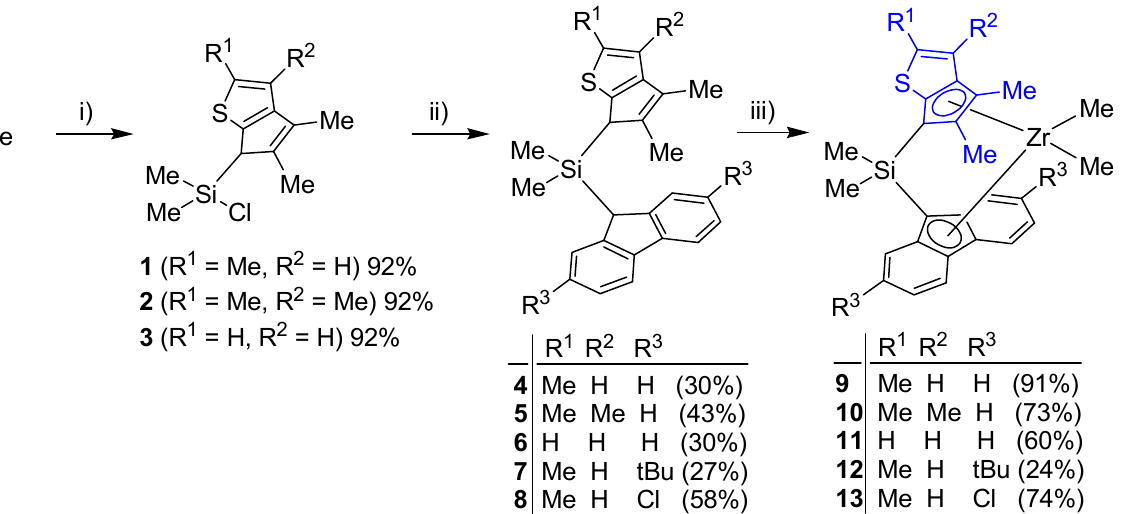
Scheme 2. Syntheses of Me 2 Si-bridged ansa -zirconocene complexes coordinated by thiophene-fused cyclopentadienyl and fluorenyl ligands: ( i ) Me 2 SiCl 2 in toluene, ( ii ) 2,7-R 32 -fluorenyl-Li in THF, ( iii ) nBuLi (2.0 eq) in THF and then addition of MeMgBr (2.3 eq) and ZrCl 4 ⋅ (THF) 2 . Because the solids precipitated in toluene were not suitable for X-ray crystallography, we grew single crystals of 9 in a CH 2 Cl 2 solution via the slow evaporation of CH 2 Cl 2 in a closed chamber containing methylcyclohexane. The bond lengths measured by X-ray crystallography suggested an η 3 -binding mode for the fluorenyl ligand and an η 5 -binding mode for the thiophene-fused cyclopentadienyl ligand; the two Zr–C bonds in the fluorenyl ligand (Zr–C3, 2.8122(31) Å and Zr–C4, 2.807(3) Å) were too long to be considered chemical bonds (Figure 1). The closest Zr–C distance in the fluorenyl ligand (i.e., Zr–C1, 2.438(3) Å) was shorter than that in the thiophene-fused cyclopentadienyl ligand (i.e., Zr–C14, 2.485(3) Å). The bridged Si atom was located slightly out of the plane formed by either the fluorenyl ligand or the thiophene-fused cyclopentadienyl ligand (Si–C14-centroid of C14–C15–C16–C17–C18 ring, 159.2 ◦ ; Si–C1-centroid of C1–C2–C3–C4–C5 ring, 168.2 ◦ ).